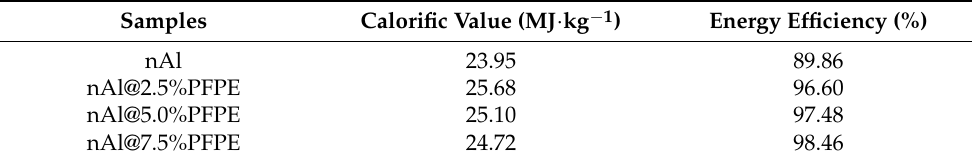
Table 1. Test results of the calorific value and calculated energy efficiency.